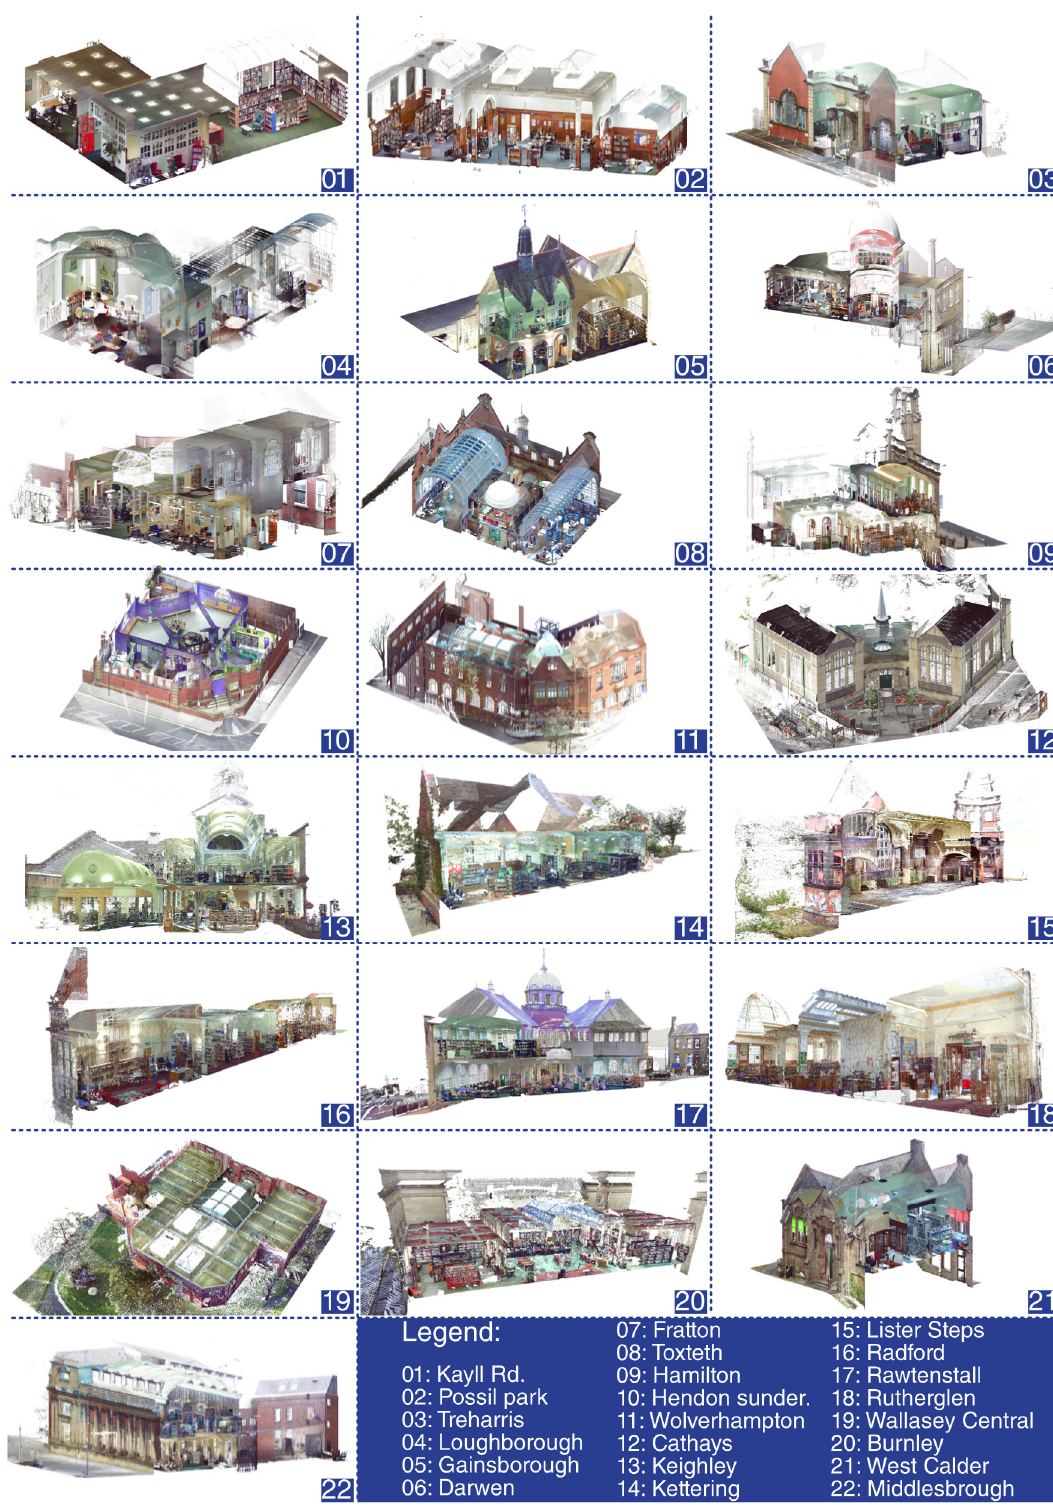
Figure 5. Laser scanned libraries.